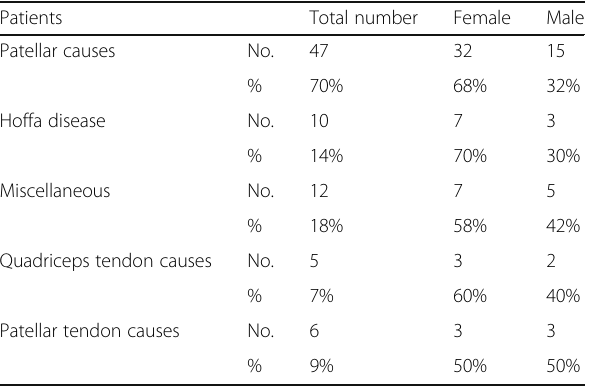
Table 5 Demonstrating the number (No.) and the percentage (%) of the prevalence of different causes of anterior knee pain (AKP) by sex Patients Patellar causes